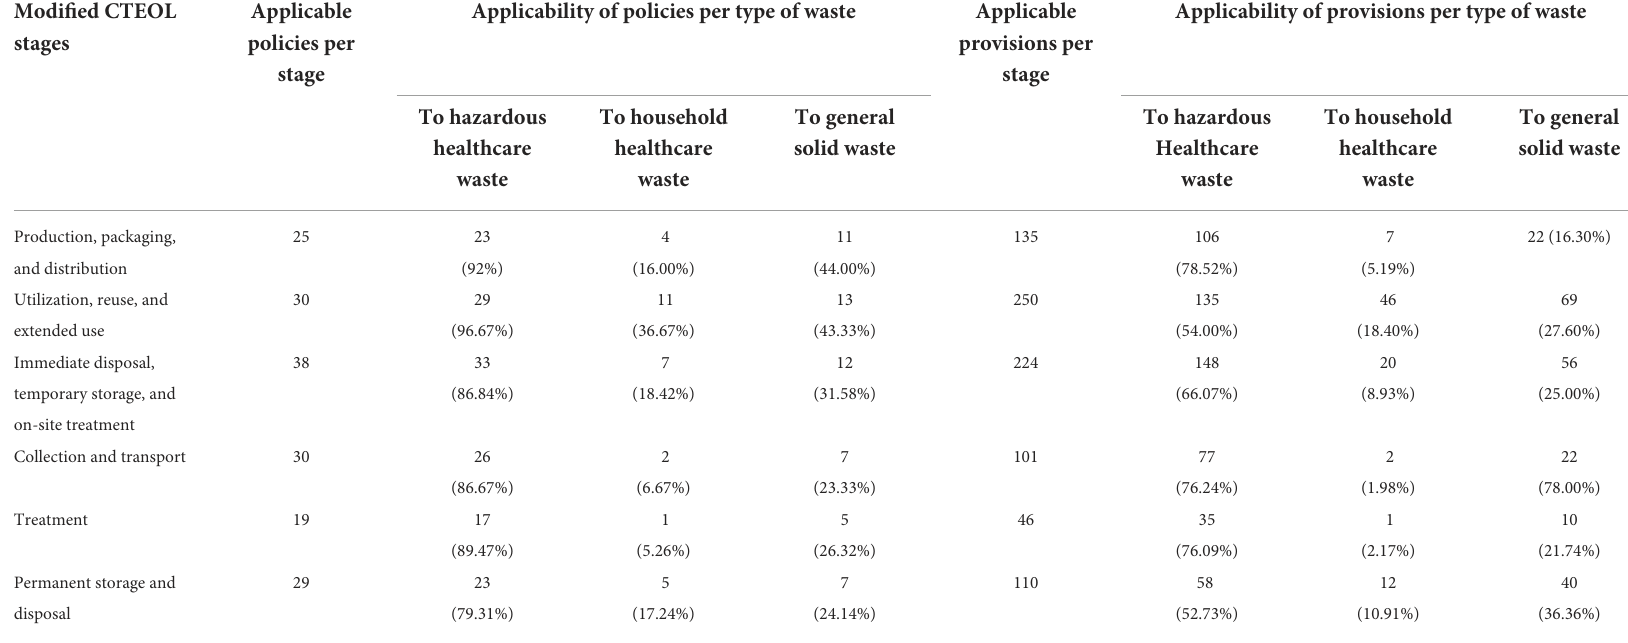
TABLE 3 Applicability of policies and provisions at each stage of waste management life